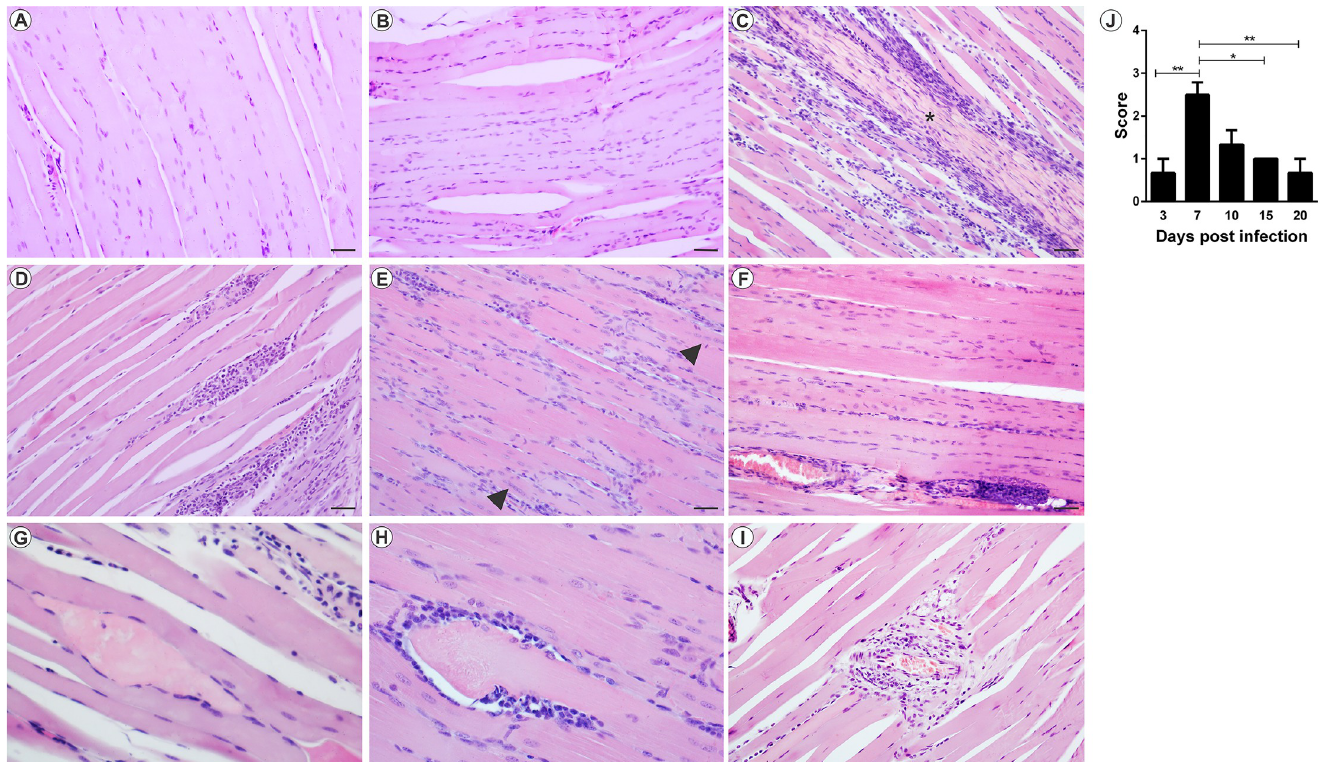
Fig 5. Mayaro virus-induced myositis in the ipsilateral muscle in mice infected below the right forelimb with 1.25x10 7 PFU. The animals were sacrificed on days 3, 7, 10, 15 and 20 PI. for tissue damage analysis. The quadricep muscle was fixed in Karnovsky, embedded in paraffin, and 5 μ m sections were made and stained with HE. (A) Negative control. (B) MAYV infection at 3 days PI. (C) MAYV infection at 7 days PI (D) MAYV infection at 10 days PI (E) MAYV infection at 15 days PI. Fibers with centralized nuclei (arrowhead). (F) MAYV infection at 20 days PI. (G) Fiber in degeneration, with pale color and swollen appearance. (H) Region of degenerating fiber undergoing phagocytosis. (I) Vasculitis. (J) Histological score. Images A, B, C, D, E, F and I (200X magnification, 40 μ m bar); G and H pictures (magnification 400X, bar 40 uM). N = 3